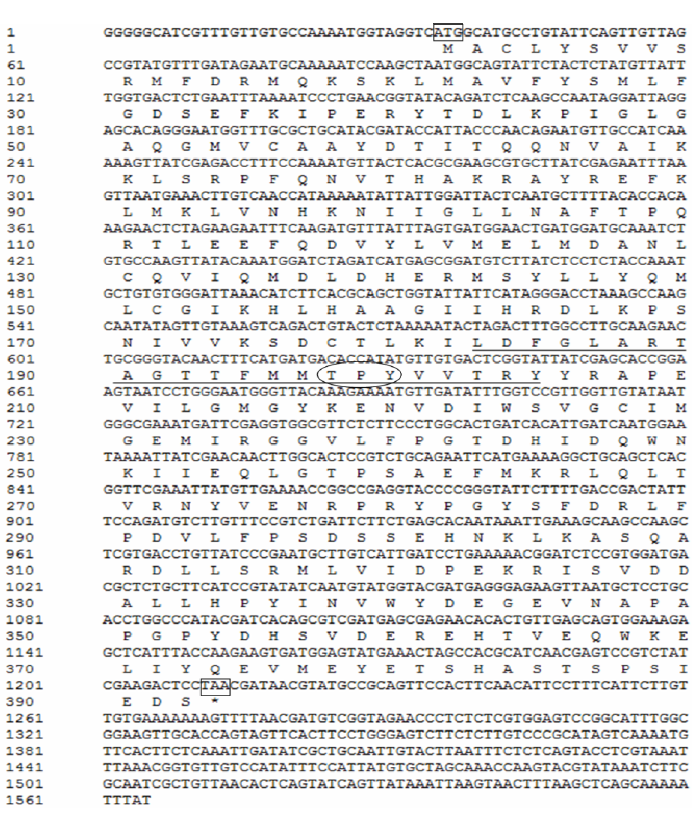
-terminal kinase 2